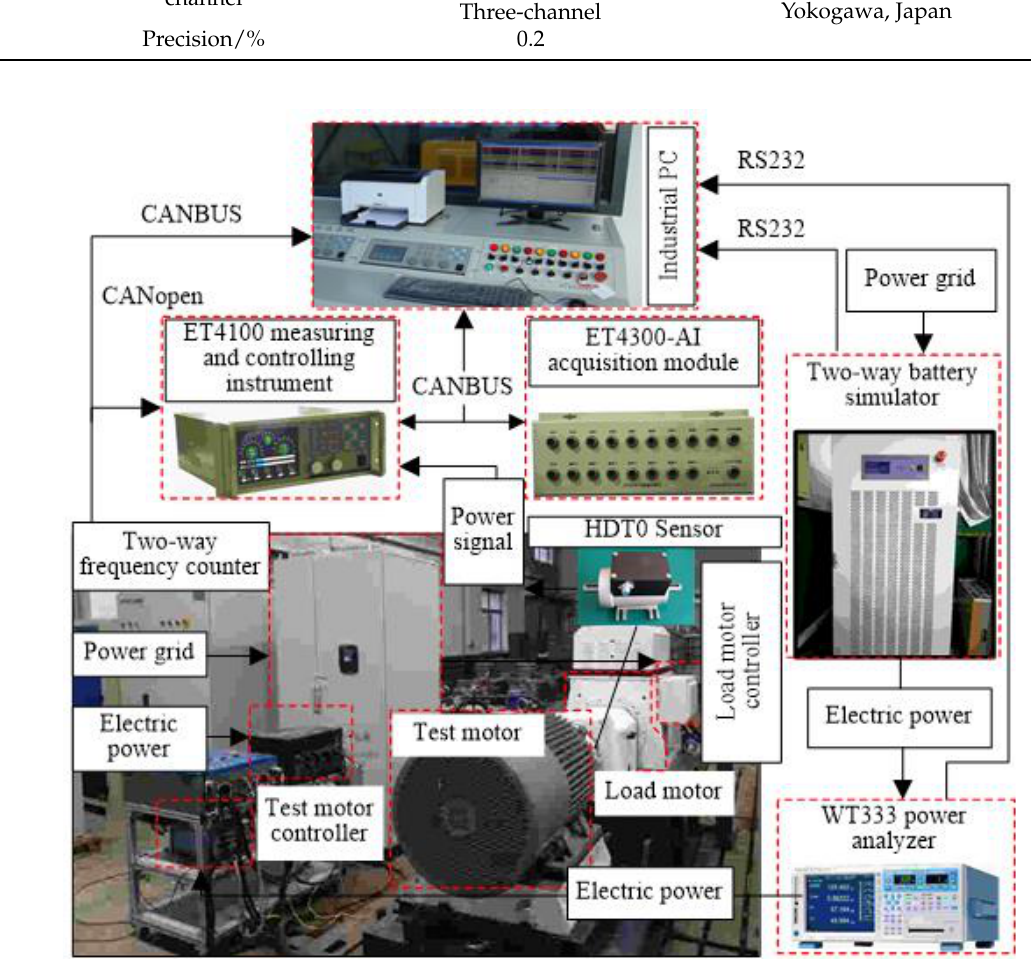
Figure 5. Measurement experiment of the drive system.